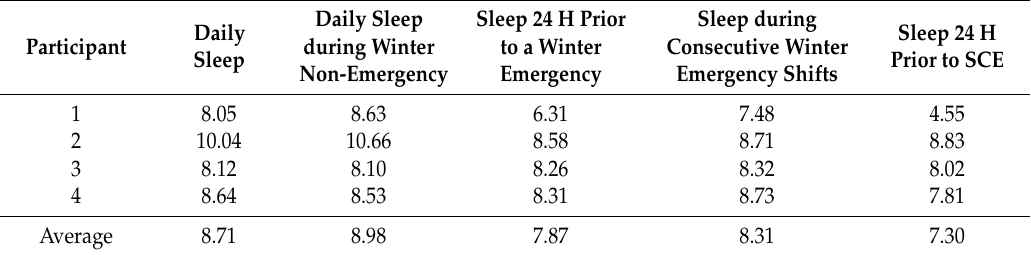
Table 4. Summary of drivers’ sleep (in